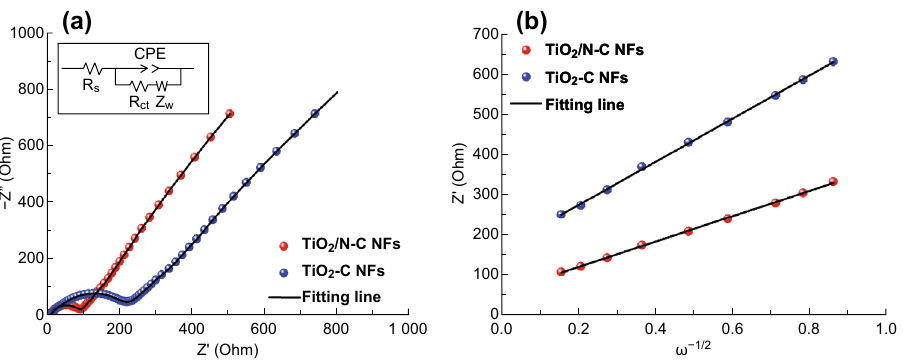
Fig. 8 a Nyquist plots of TiO 2 /N–C NF and TiO 2 –C NF electrodes measured after the first cycle at 0.05 A g - 1 . (The inset shows the equivalent circuit model.) b Relationship between Z 0 and x - 1/2 at low frequency